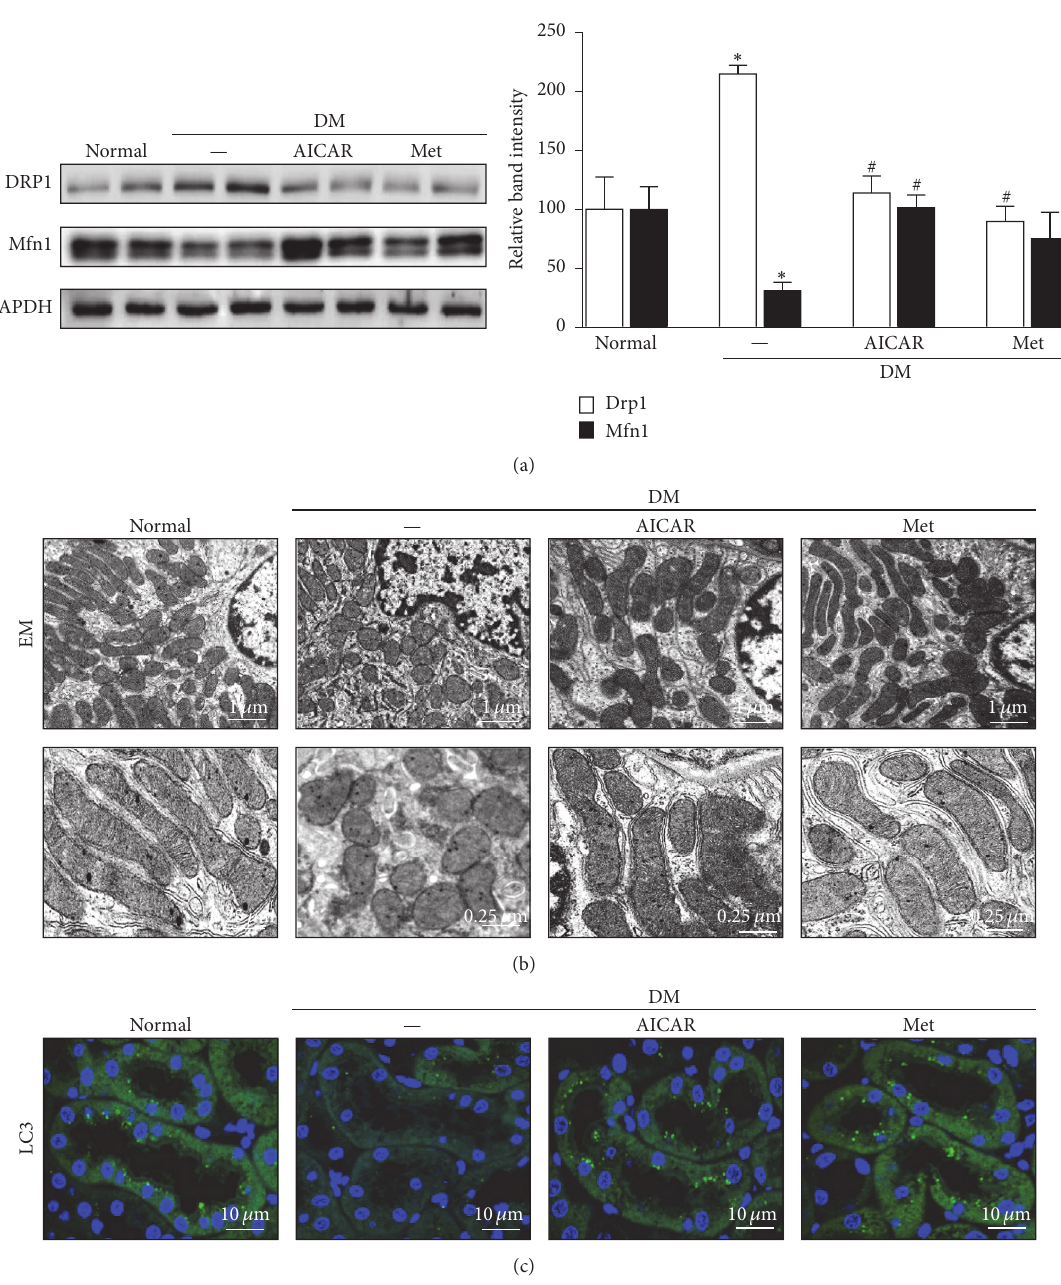
Figure 7: Restoration of altered mitochondrial dynamics and autophagy in STZ-induced diabetic mice after treatment of AICAR or metformin. (a) Western blot analysis revealed that AICAR or metformin treatment reverses the changes in the expression of Drp1 and Mfn1 in diabetic kidneys. (b) Electron micrographs of mitochondria in renal tubular cells. The control group displayed elongated mitochondria, whereas the diabetic group displayed short or spherical shaped mitochondria. The administration of AICAR or metformin markedly attenuated mitochondrial fragmentation in the renal tubular cells of diabetic kidneys. (c) The basal level of autophagy, indicated by punctate LC3 staining, was seen in the renal tubules of the control group and was decreased in the tubules of the diabetic group. Notably, autophagic activity was restored in the AICAR and metformin groups ( ∗ 𝑝 < 0.05 versus normal; # 𝑝 < 0.05 versus diabetic